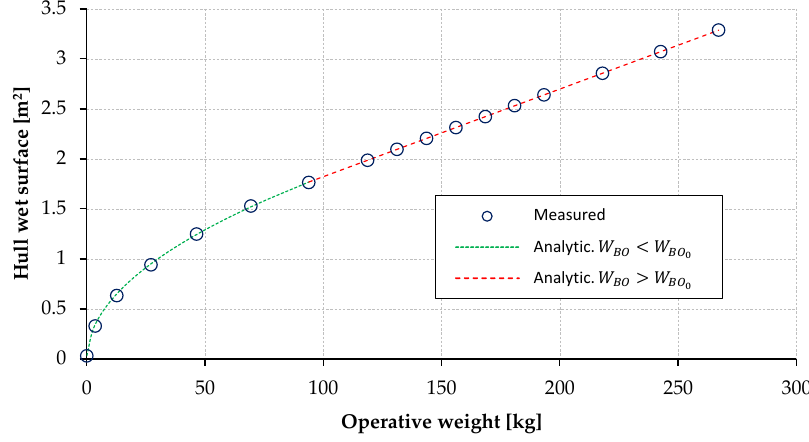
Figure 4. Hull wet surface of the reference demihull.